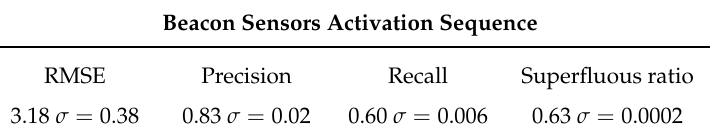
Table 6. SAS analysis for beacon sensors with W = 7 min.